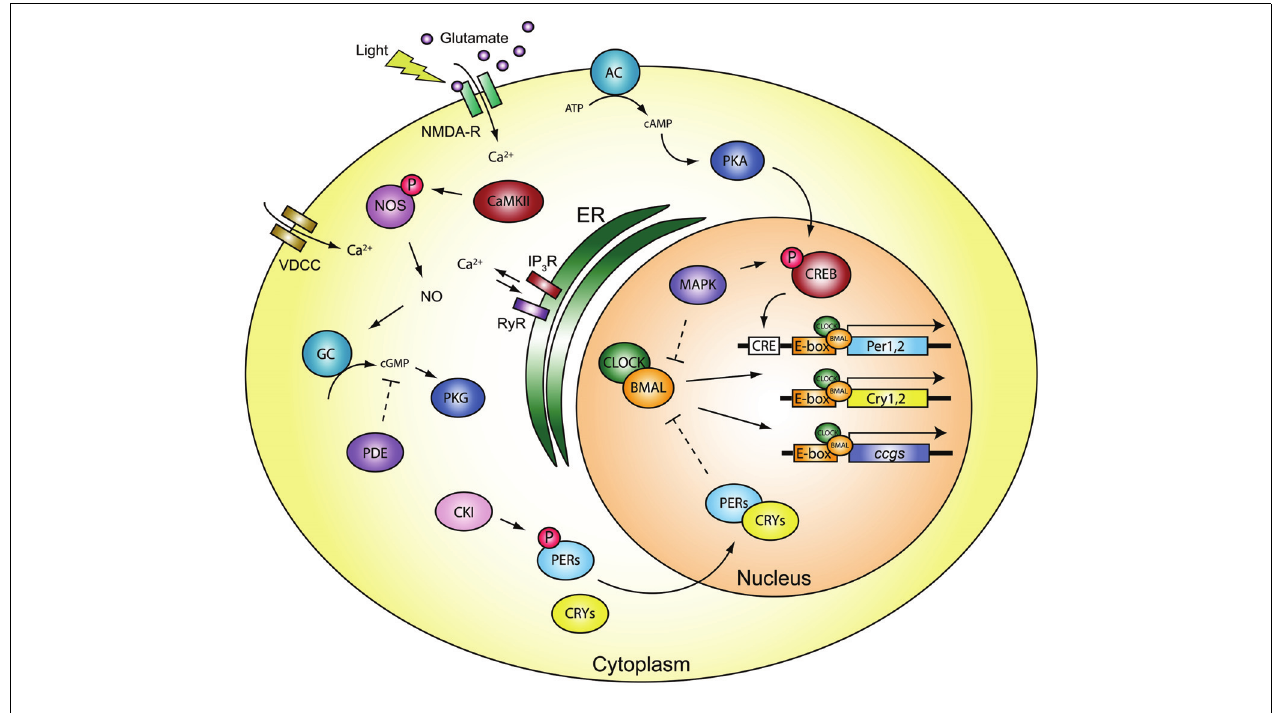
varying degrees based on the time-of-day.This shifting balance in the capacity of the system to regulate changes in behavioral output differentially is central to the notion of circadian metaplasticity in physiology and behavior. Refer to text for further information regarding the signaling pathways and